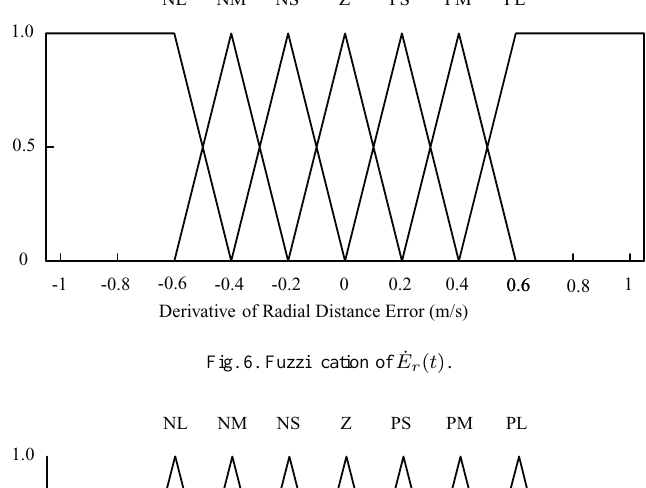
Fig. 6. Fuzzification of ˙ E r ( t ) .